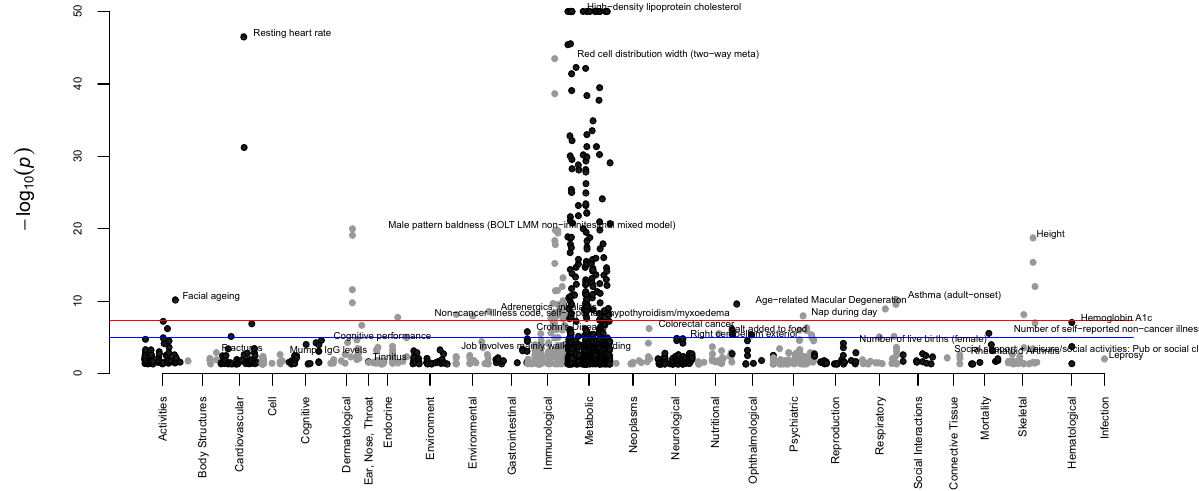
Figure 5. Results of the phenome-wide association study of the six genetic determinants of the blood pressure related phospholipids. In each domain (x-axis), the top trait was annotated in the figure. The traits with P-value level less than 1.0 × 10 −50 were annotated as 1.0 × 10 −50 in the figure. The dots depict the P -values from